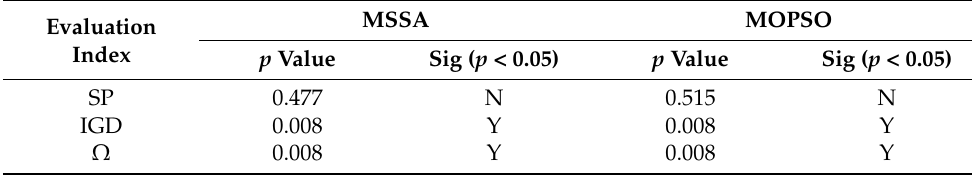
Table 5. Wilcoxon signed-rank test (the MHSSA vs. the MSSA and the MOPSO).